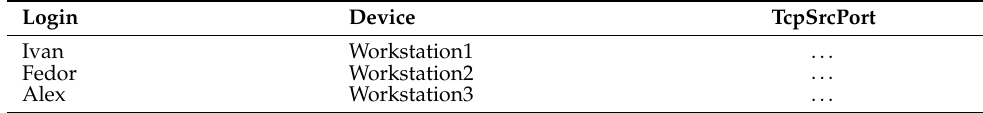
Table 9. Example of query results of the algorithm for Feature 4.